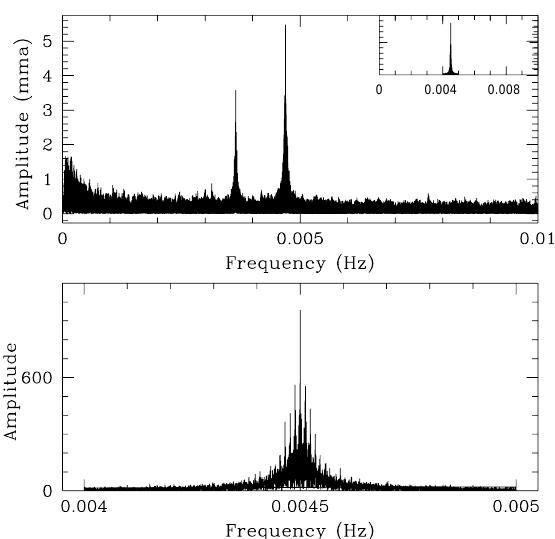
Fig. 1. Top panel shows the Fourier Transform (FT) of the data on ZZ Ceti from 1999. The lower panel indicates the window pattern, which is what a single frequency in that data set should look like in an expanded scale. The inset in the top panel shows the window pattern at the same scale as the